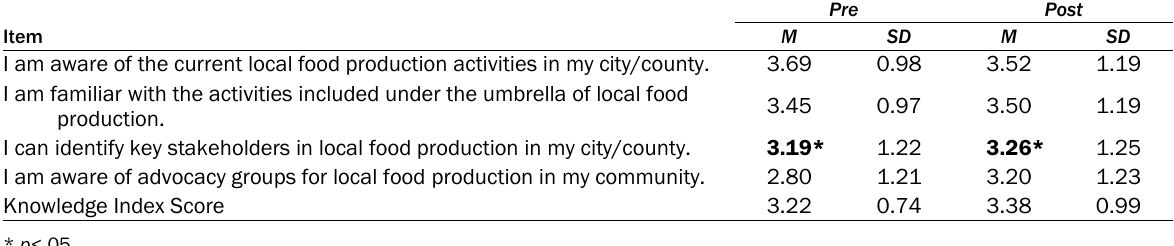
Table 12. Knowledge about Local Food Production Before and After COVID-19 ( n =42)